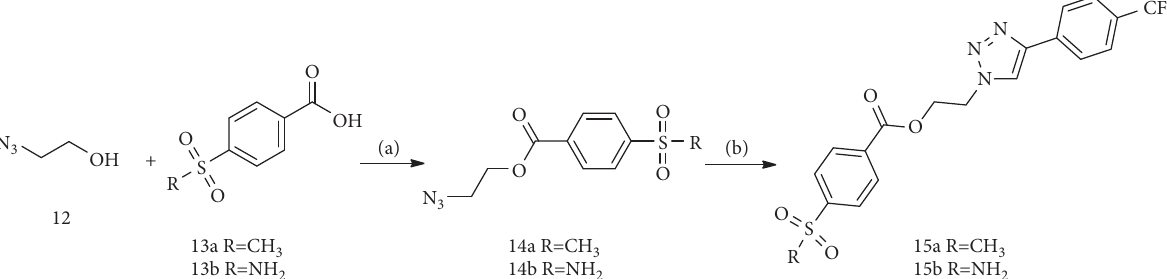
Scheme 4: Synthesis of triazole compounds ( 15a and 15b ). Reagents and conditions: (a) EDC, DMAP, and DCM; (b) 4-ethynyl- α,α,α -trifluorotoluene 7, CuSO 4 , sodium ascorbate, and DCM :H 2 O (1